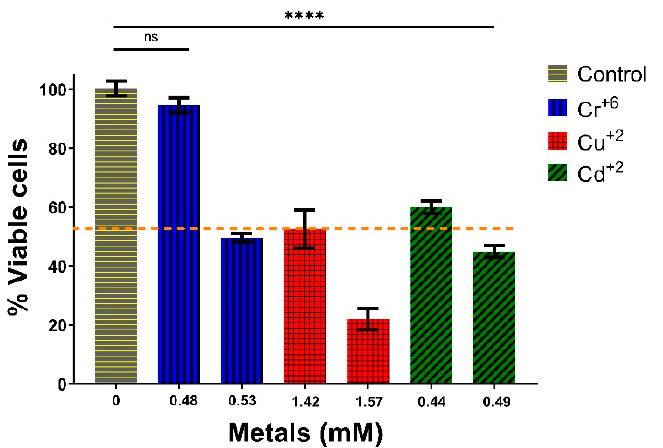
Figure 3 . Median lethal concentration (LC 50 ) of the heavy metal ions Cr +6 , Cu +2 , and Cd +2 for Y. lipo- lytica AMJ6 in YPG broth for a period of 3 h. The bars on the graph represent the mean (±SEM) of three independent experiments. The yellow dashed line indicates the concentration of metal at which 50% of the yeast population died. Statistical significance, p ≥ 0.05 (Not significant ns) and **** p < 0.0001.